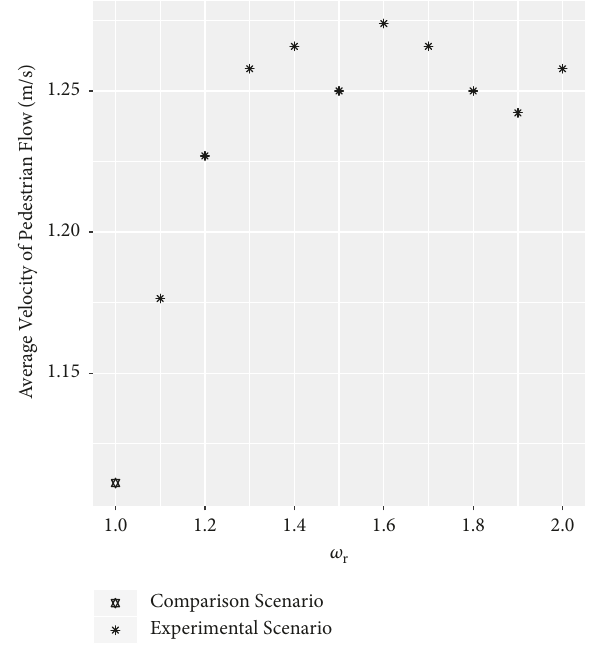
Figure 14: Average Velocity of Pedestrian Flow varying over 𝜔 𝑓 . Figure 15: Average Velocity of Pedestrian Flow varying over 𝜔